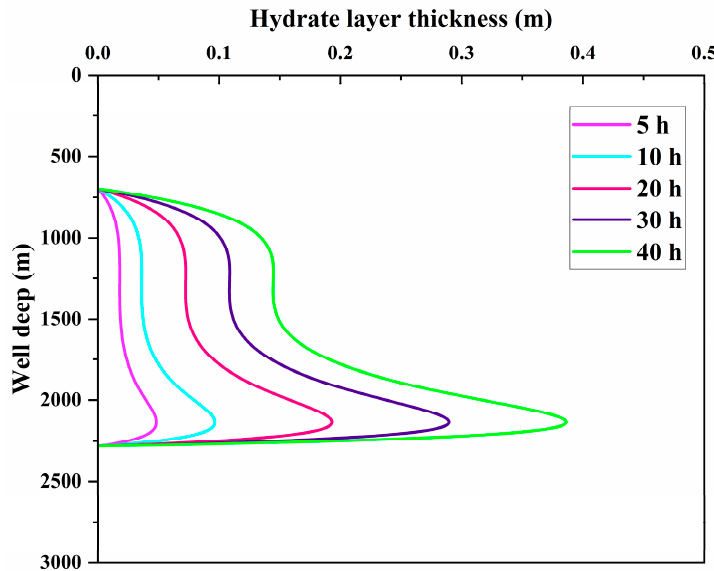
Figure 6. Variation of hydrated layer thickness with time under stop drilling condition.